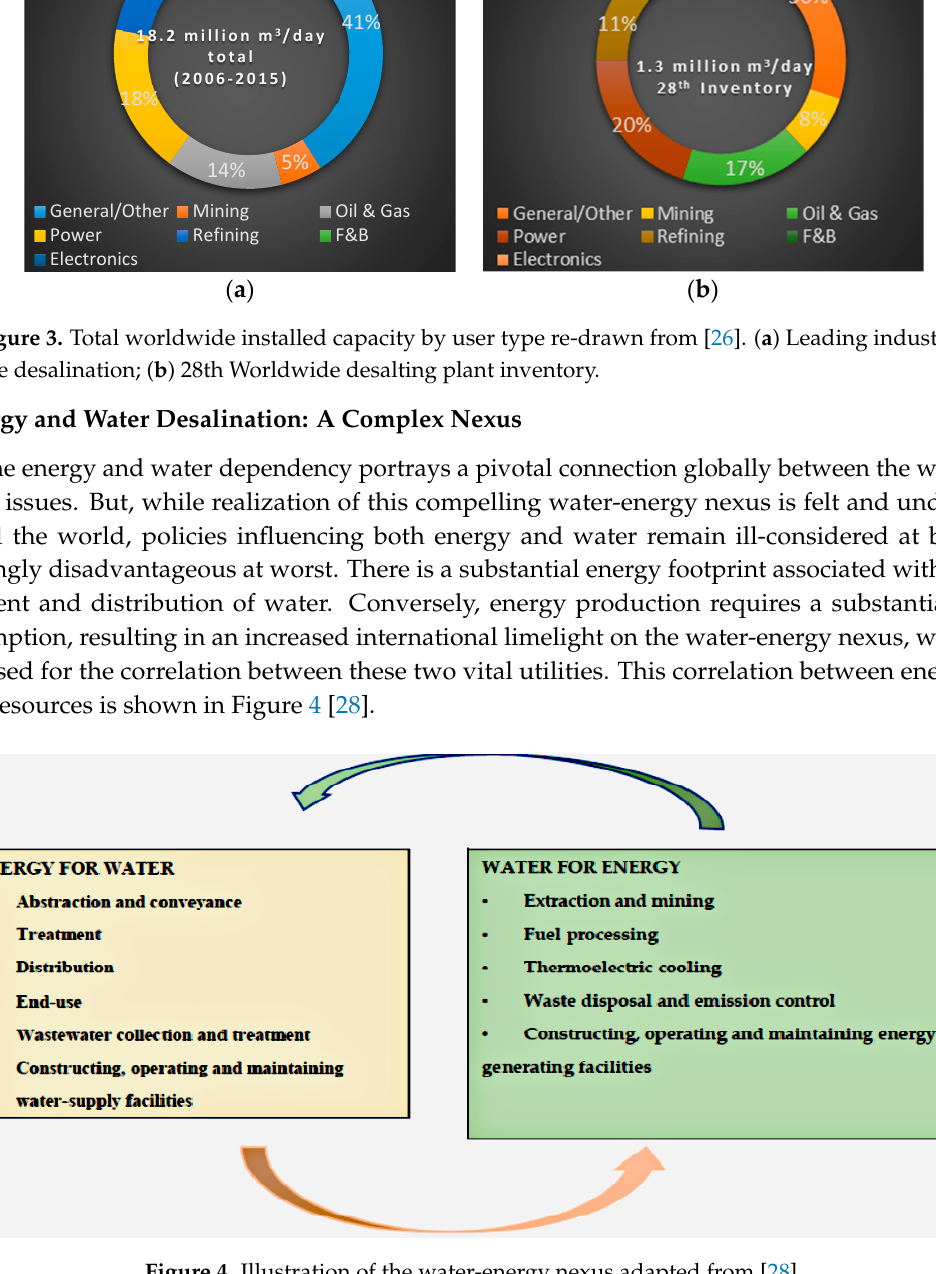
3 of 31 Figure 1. Global distribution of desalination capacities (million m 3 /day) as of 2013 [21]. Figure 2. Total global installed capacity by technology type re-drawn from [26]. The exponential increment in demand for potable water has seen a massive investment in